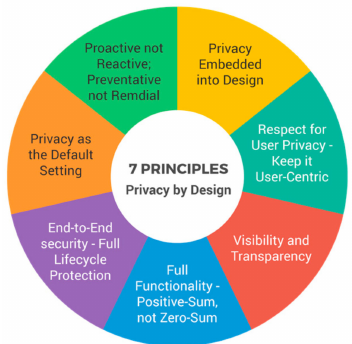
Figure 2. Seven fundamental principles of privacy by design